Question: In a single sentence, describe what this figure presents.
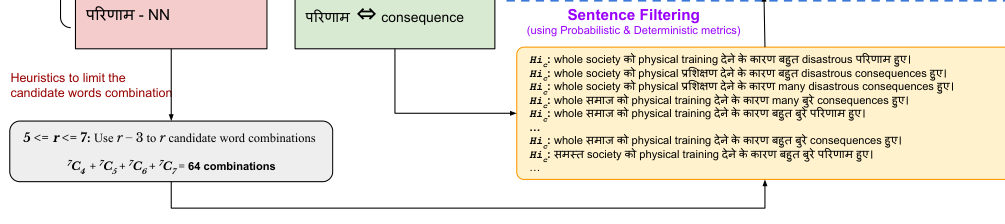
Answer: Process of code-mixed sentence generation in HINMIX.